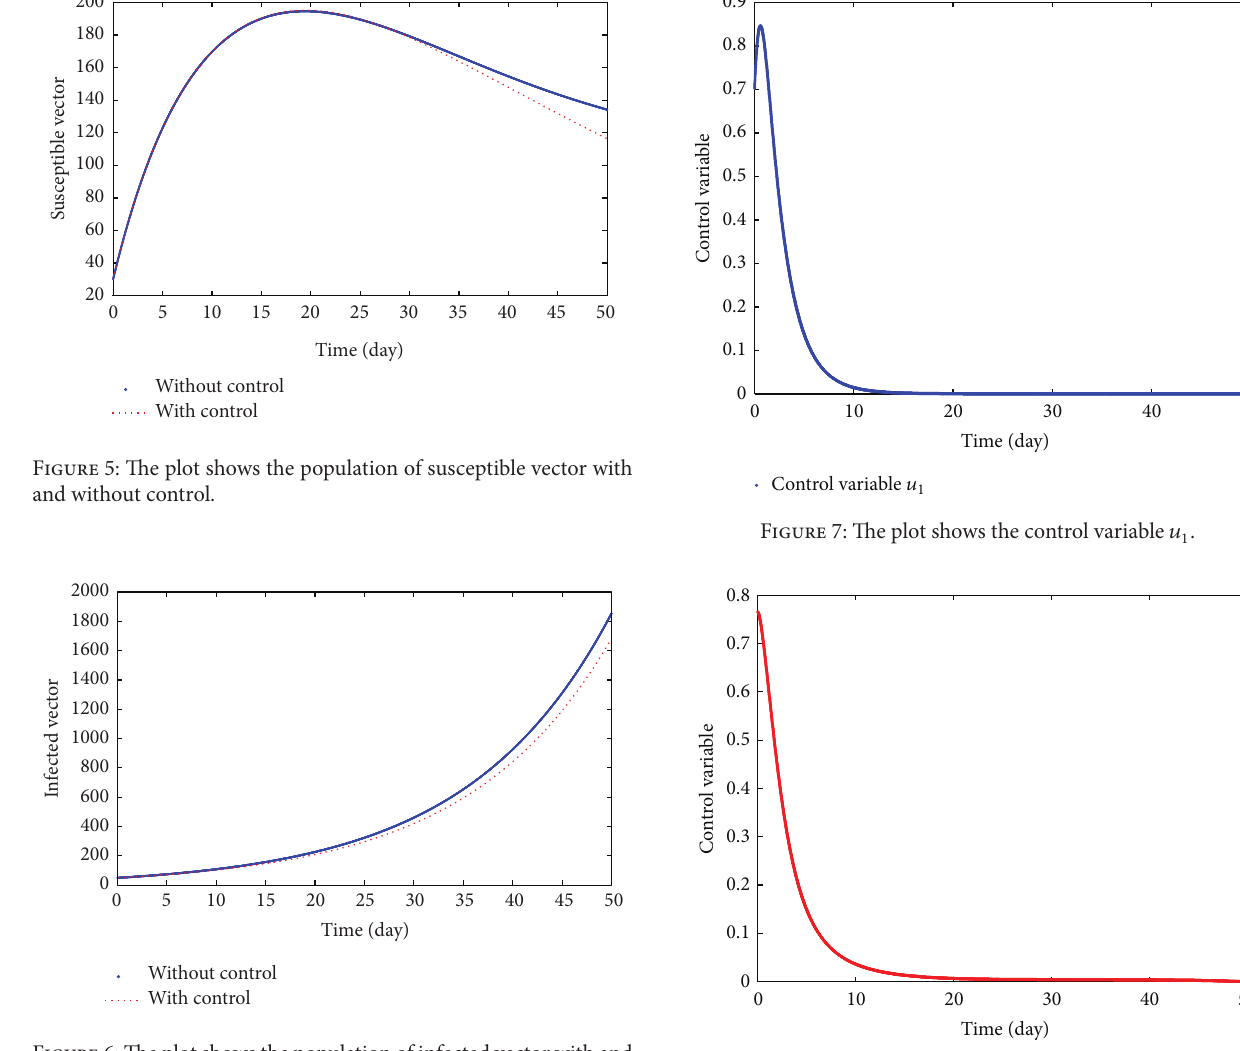
Figure 6: The plot shows the population of infected vector with and without control.